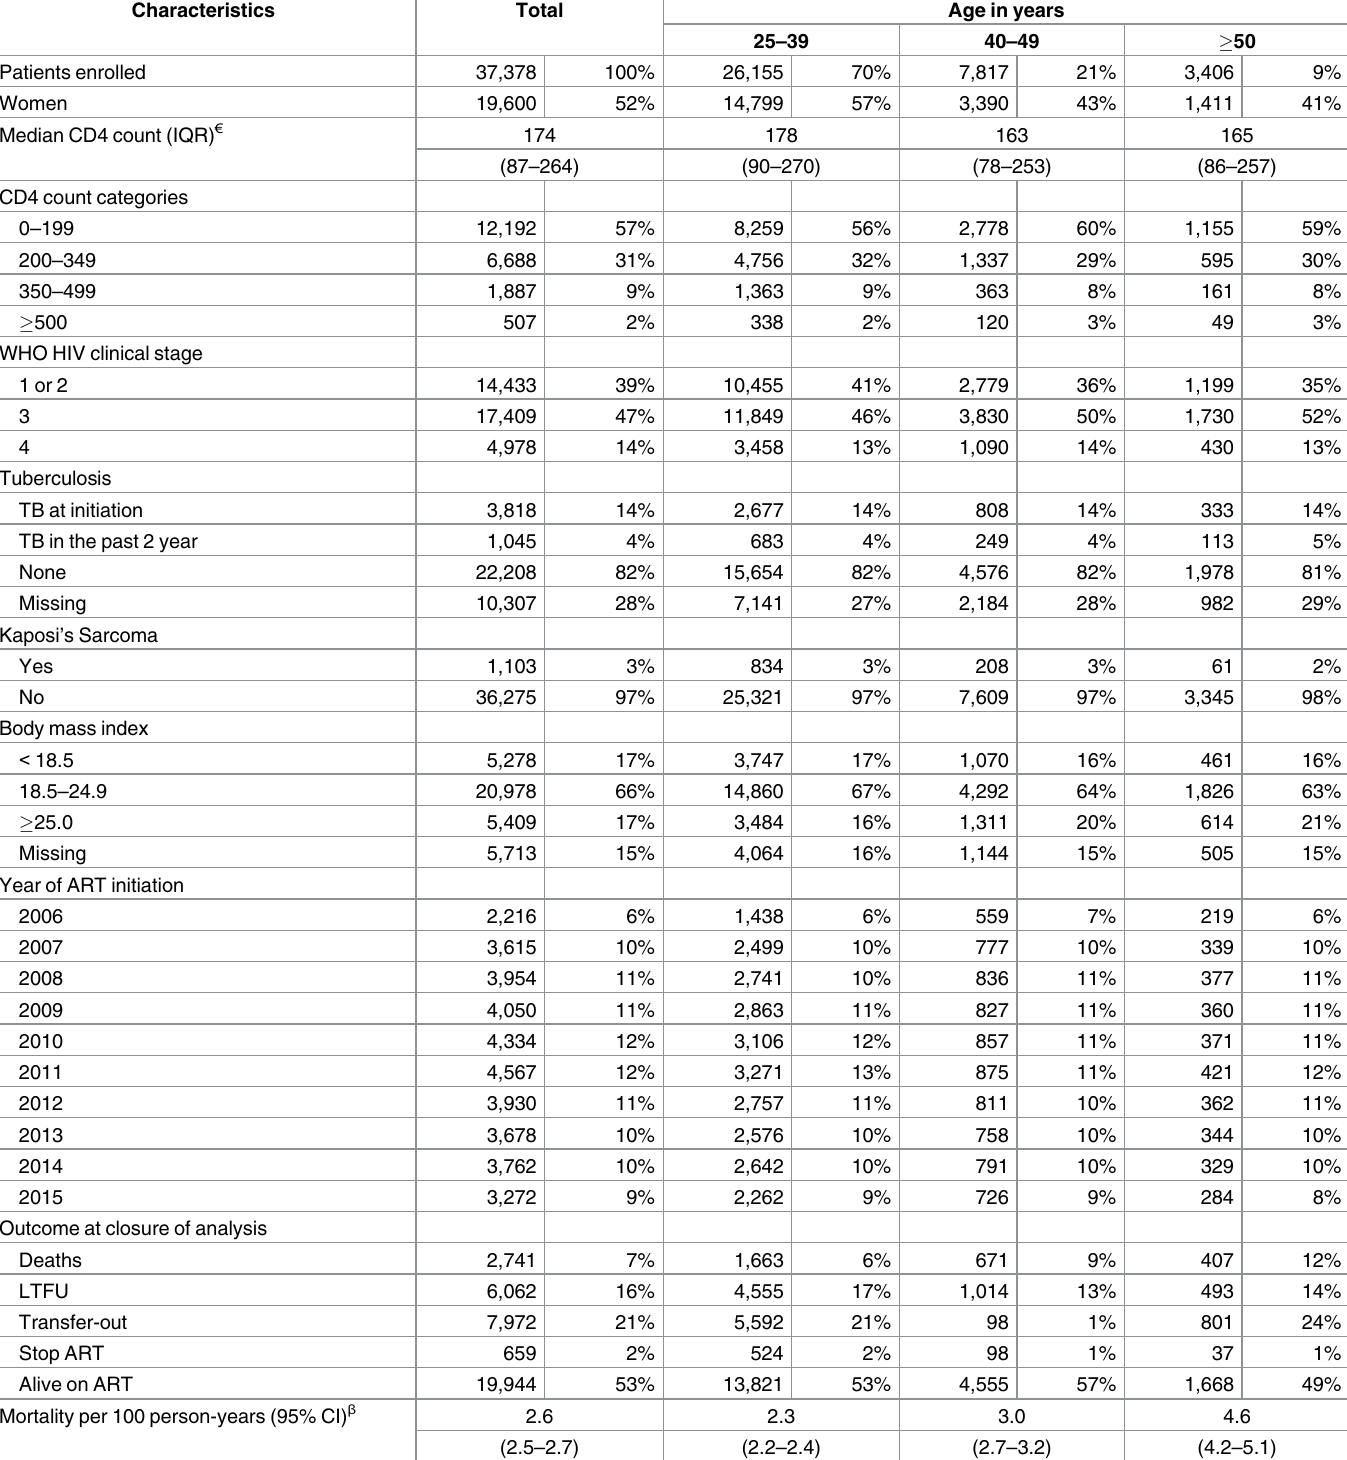
Table 1. Baseline characteristics, loss to follow-up and mortality, by age at ART initiation between 2006and 2015 at Lighthouse and Martin Preuss clinics, Malawi.